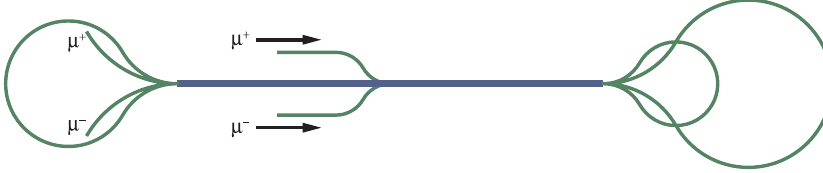
FIG. 23. (Color) Dog-bone (top) and racetrack (bottom) layout for the RLA.